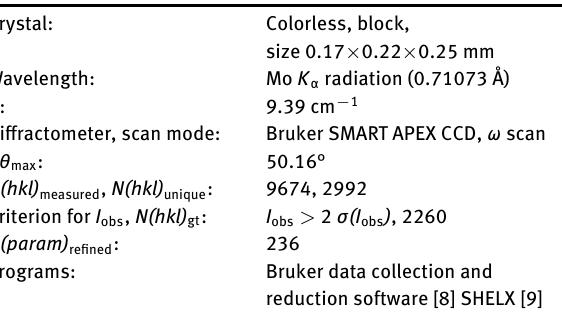
Table 1: Data collection and handling.